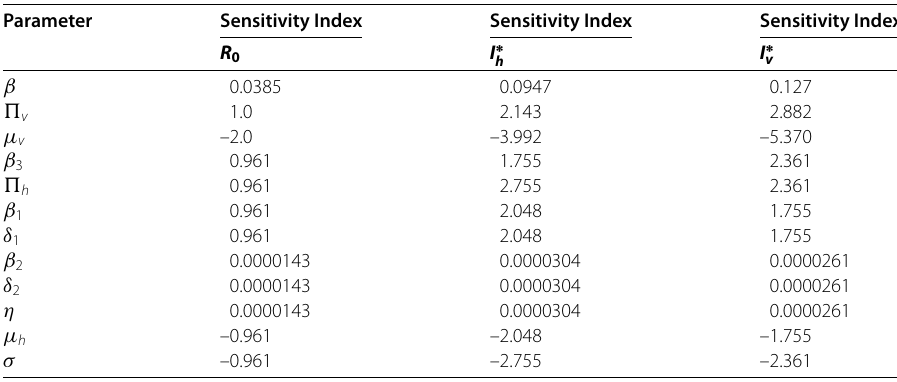
, and I ∗ v , based on the parameter values given in Table 1 h